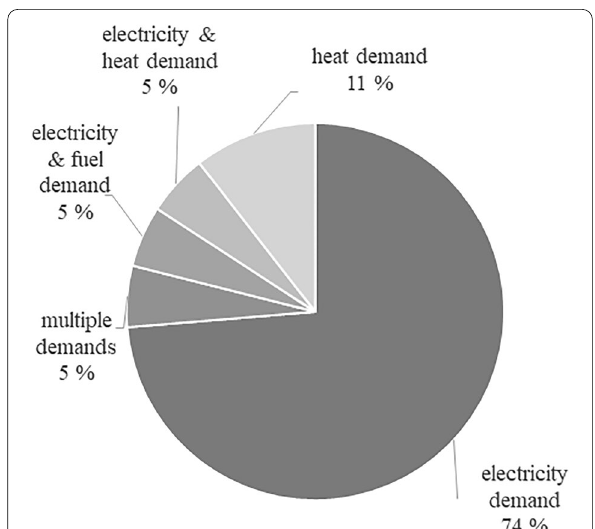
Fig. 4 Aim of flexibilization of CHP plants investigated in studies, n =